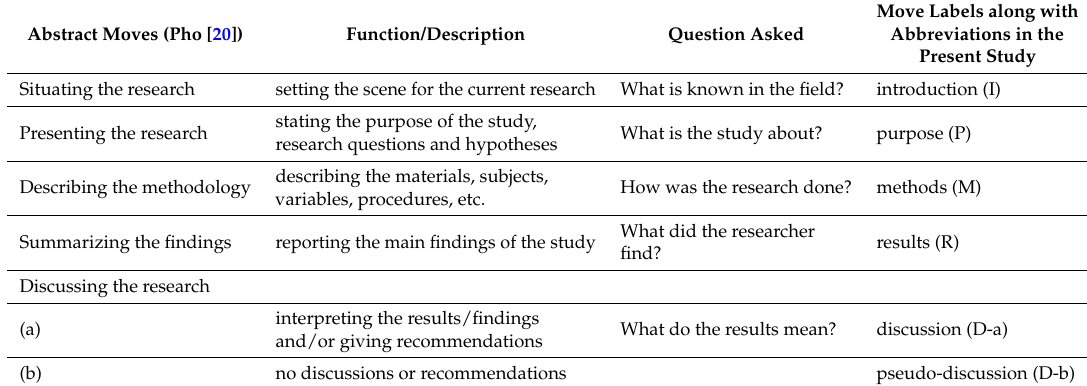
Table 2. Framework for move coding in the current study, adapted from Pho